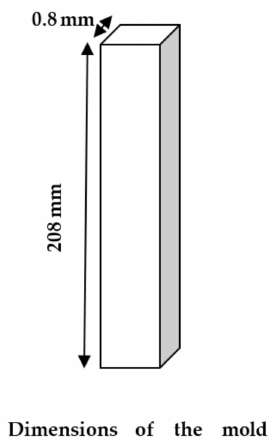
Figure A2. Mold cavity